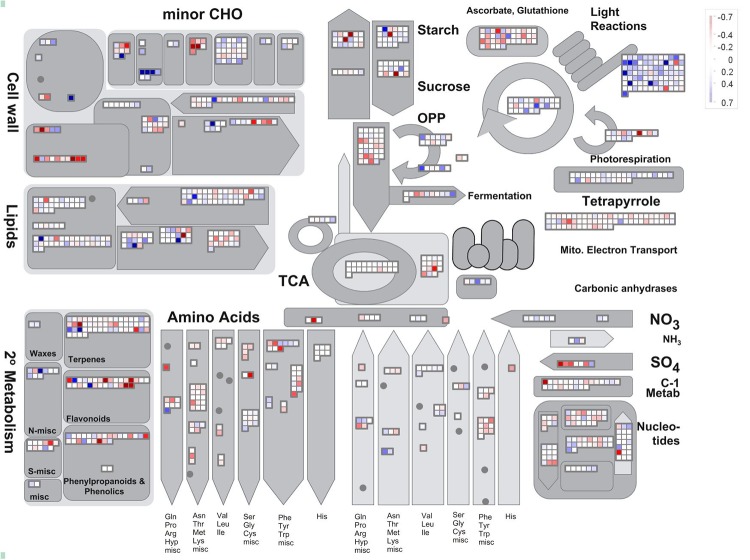
Pathway analysis of genes expressed in the E. melliodora mosaic.Blue squares indicate transcripts with higher levels of abundance in the leaves of the susceptible branch and red squares indicate transcripts more abundant in the leaves of the resistant branch. The intensity of the colour indicates the level of differential abundance of a transcript.